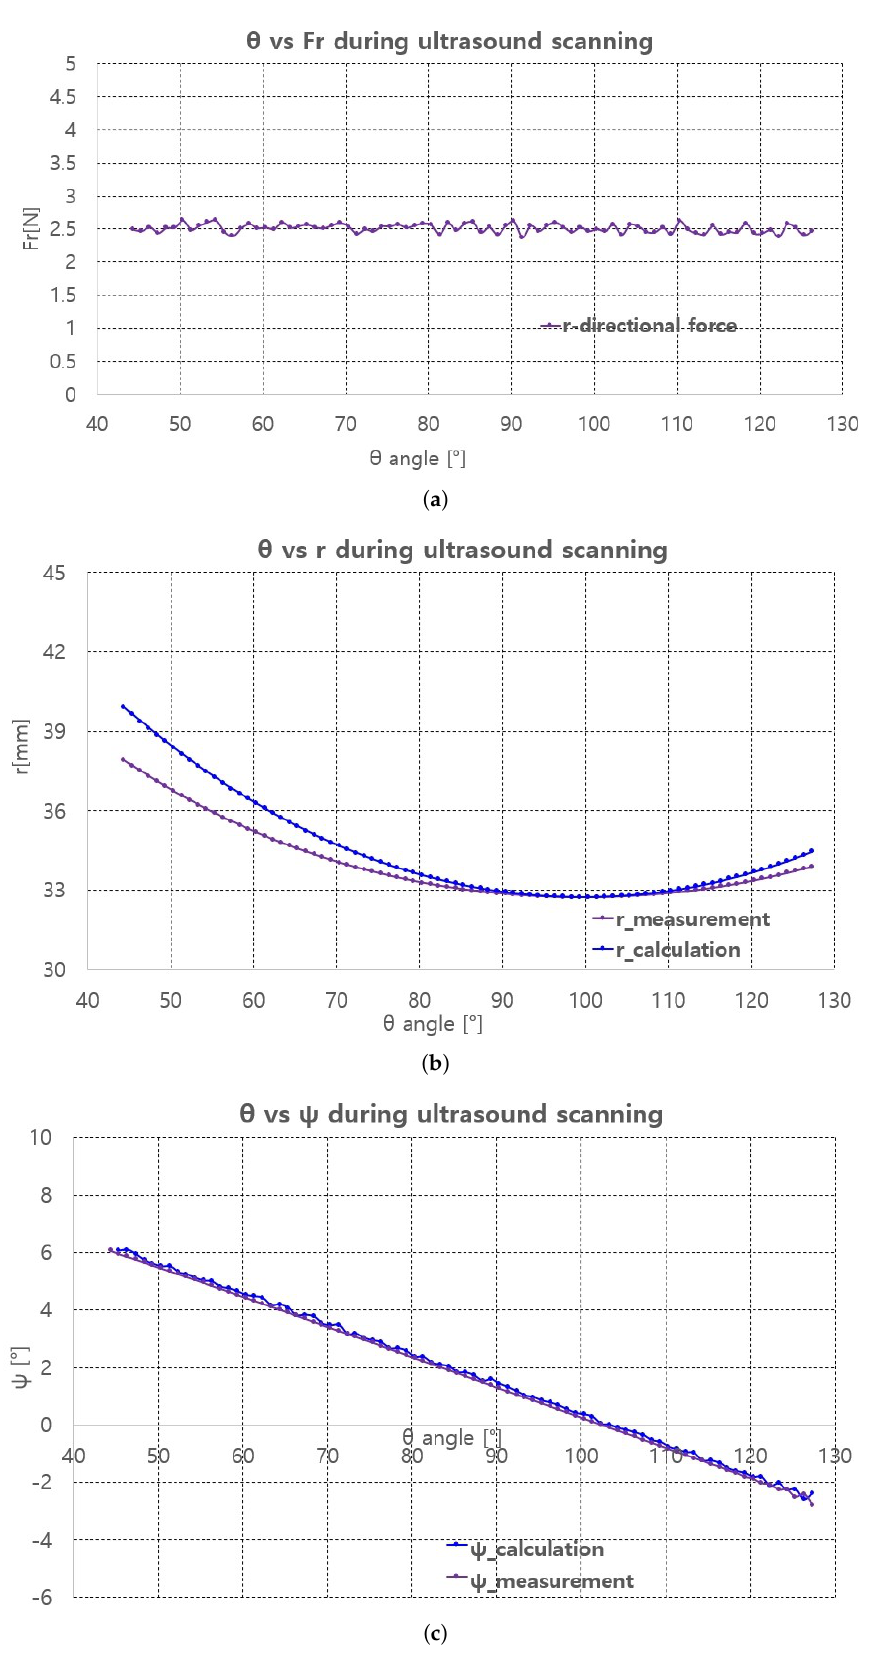
Figure 17. Fr, r, ψ measurement and calculation with respect to θ . ( a ) r-directional force measurement. ( b ) r measument and calculation. ( c ) ψ measument and